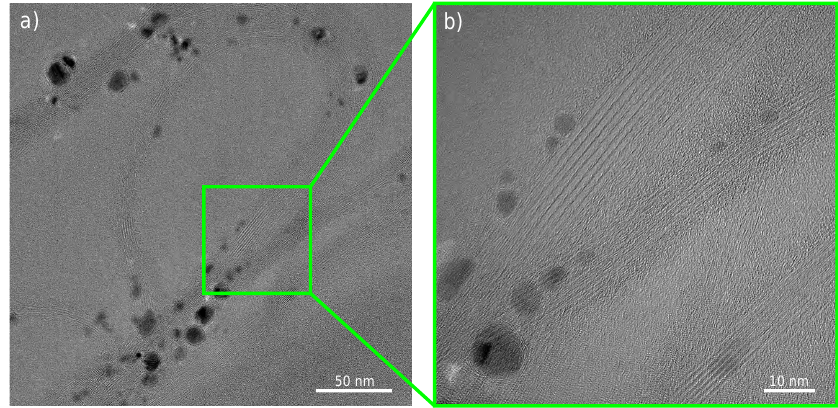
Figure A19. TEM images for Tuball 75 at ( a ) low magnification and ( b ) high magnification [27].